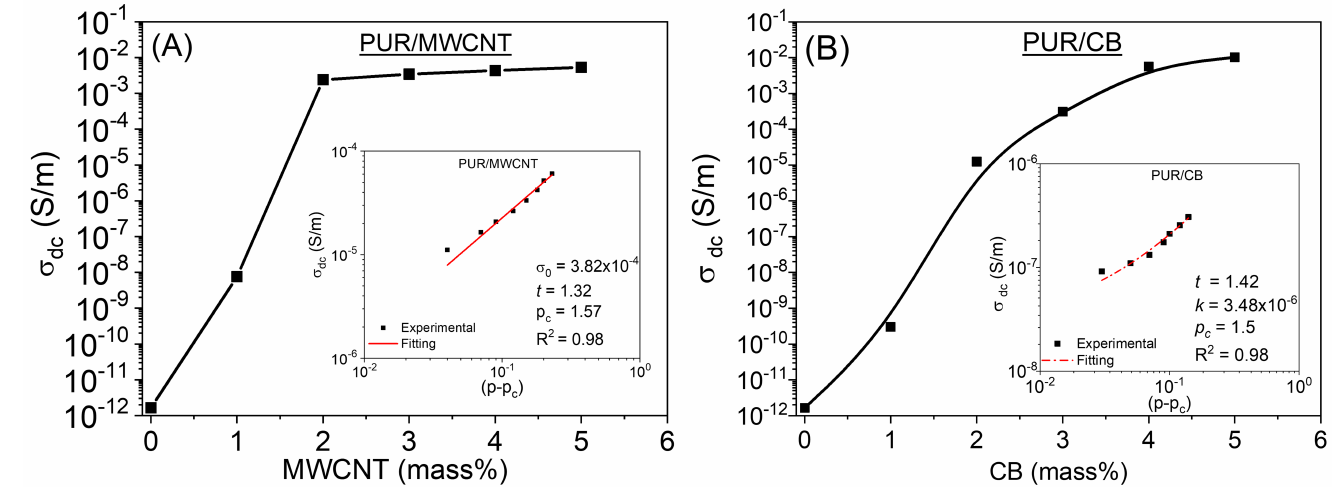
Figure 3. σ dc behavior in relation to the conductive nanofiller mass fractions for ( A ) PUR/MWCNT and ( B ) PUR/CB nanocomposite. The Figure presents the double-logarithmic plot, based on Equa- tion (2), for the PUR/MWCNT nanocomposite and for the PUR/CB